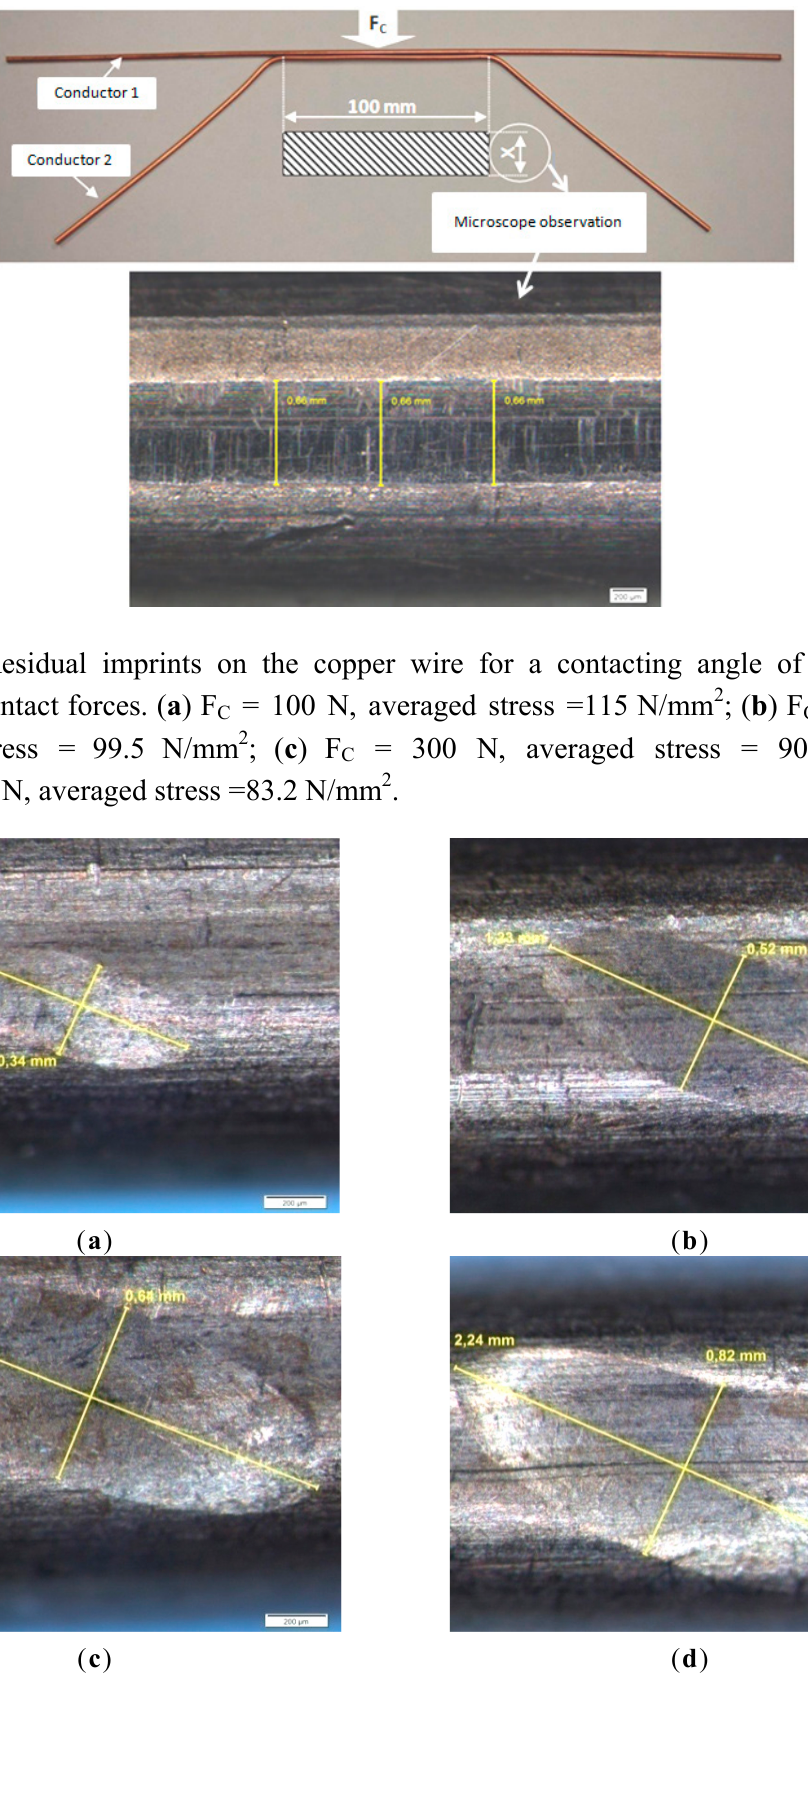
Figure 6. Measurement of the imprint at a crossing angle 0° for a contacting force of 480 N. and a stress of 7.27 N/mm 2 .